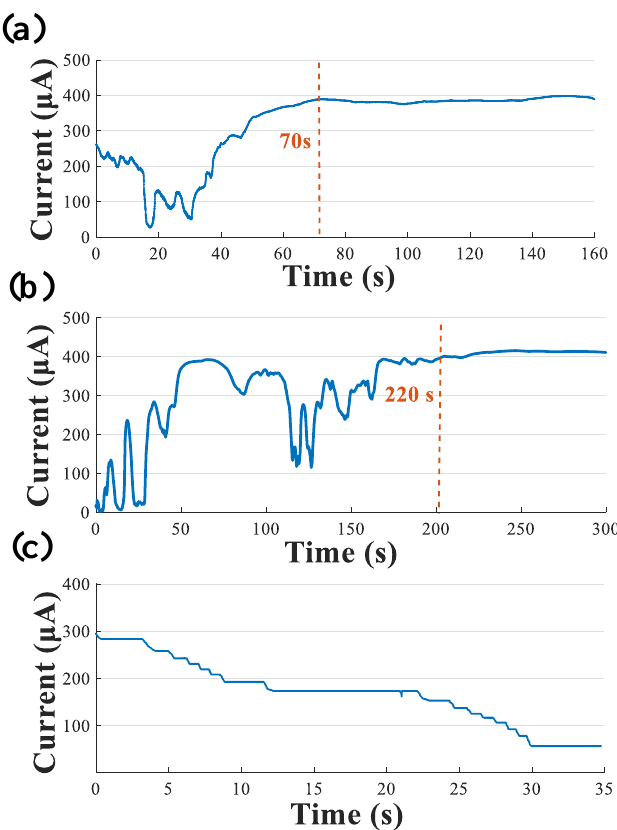
Figure 5. Acute in vivo current conduction experiment. ( a ) The shunt-current density measured in the range of 750-3000 μA; ( b ) the shunt-current density measured in the range of 90-780 μA; ( c ) the shunt-current density when the terminal potential was adjusted.